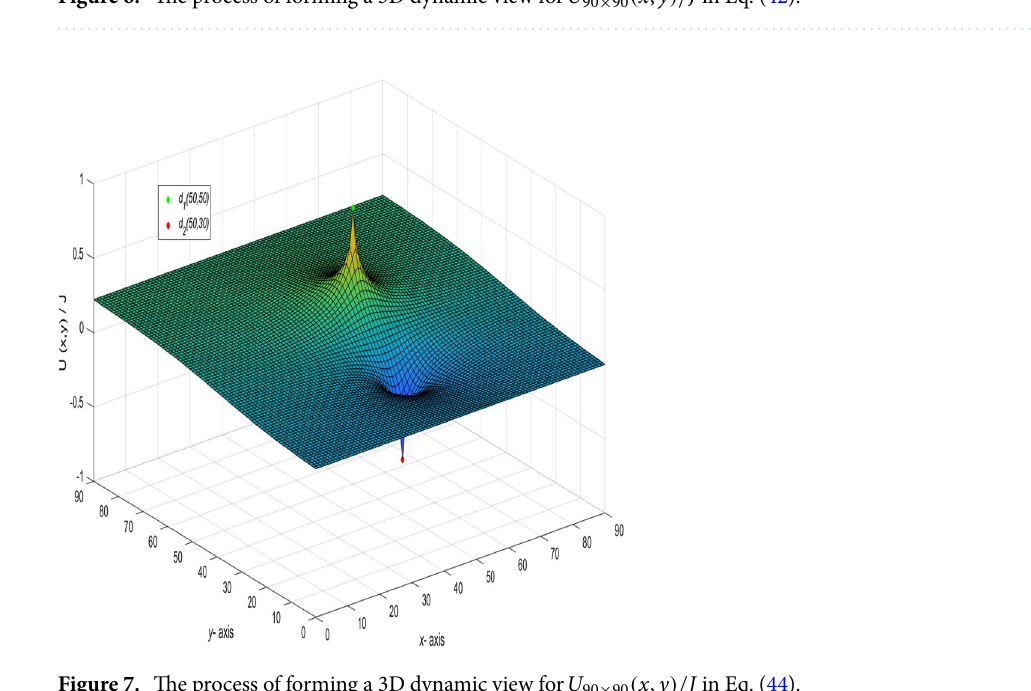
Figure 6. The process of forming a 3D dynamic view for U 90